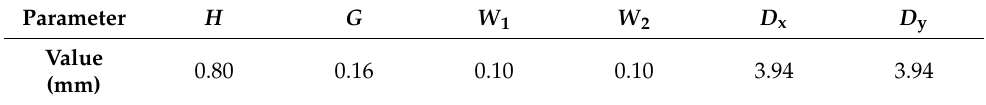
Table 1. Parameter values shown in Figure 2.